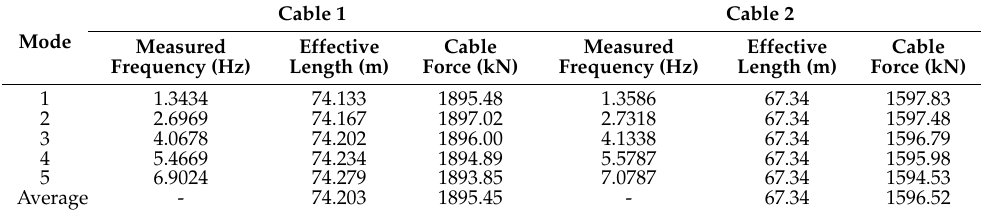
Table 6. Cable effective vibration lengths of the single Cable 1.